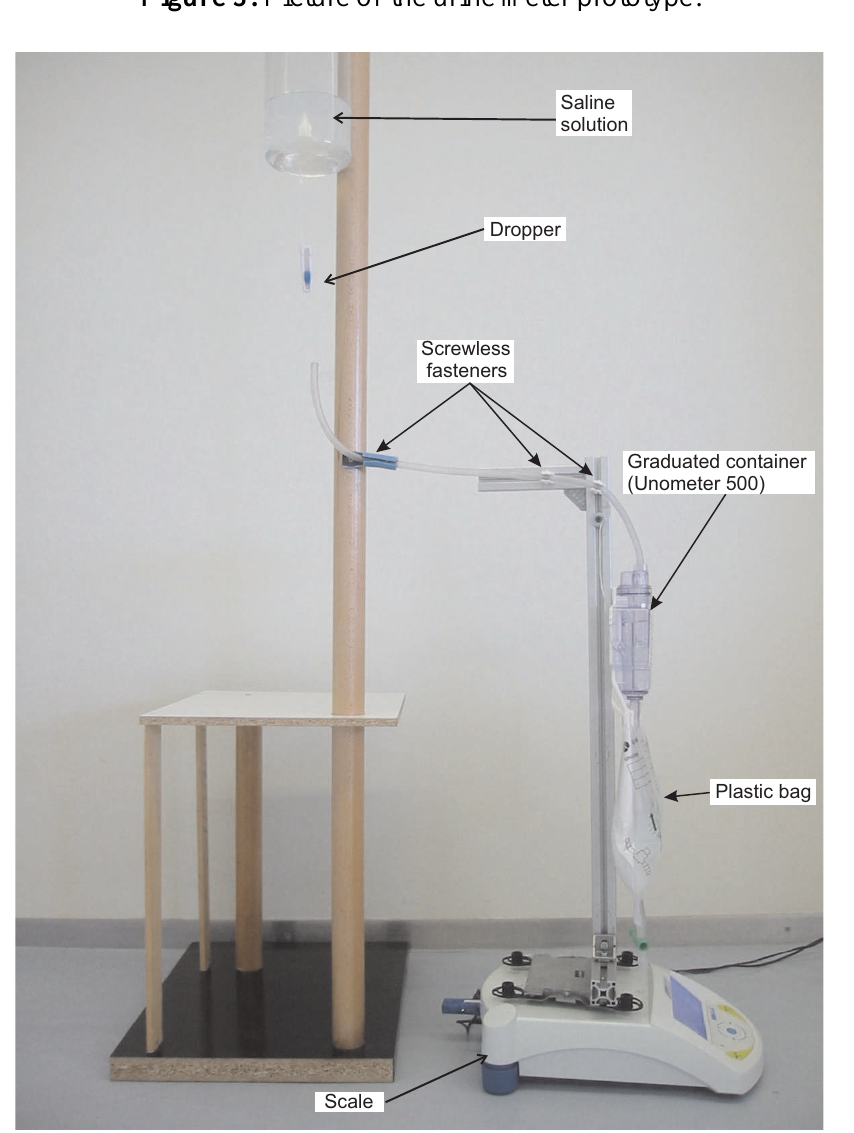
Figure 3. Picture of the urine meter